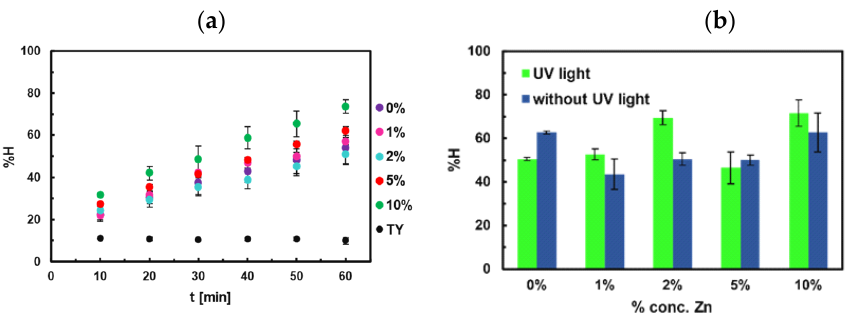
Figure 14. Efficiency of ( a ) photodegradation process by Fe 3 O 4 , Fe 3 O 4 @1%Zn, Fe 3 O 4 @2%Zn, Fe 3 O 4 @5%Zn, and Fe 3 O 4 @10%Zn nanoparticles after 60 min exposure time and ( b ) photo-assisted removal of TY process in pH equal 7.